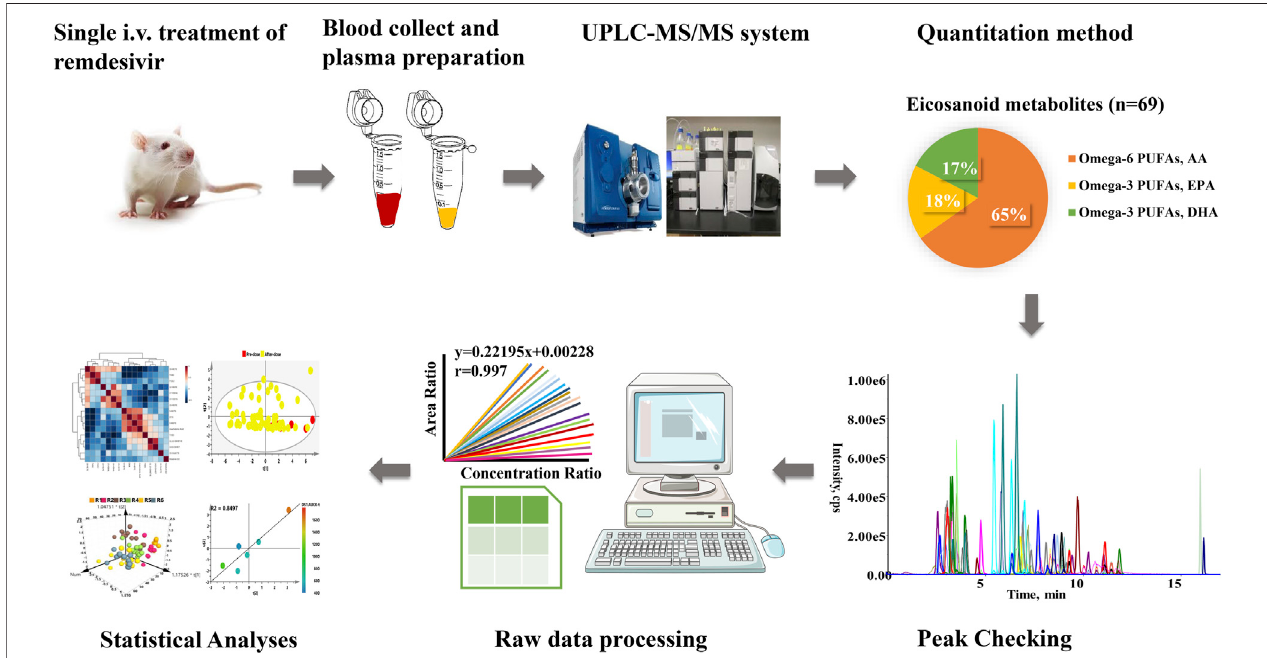
FIGURE 1 | Work fl ow of eicosanoids metabolomics applied in this